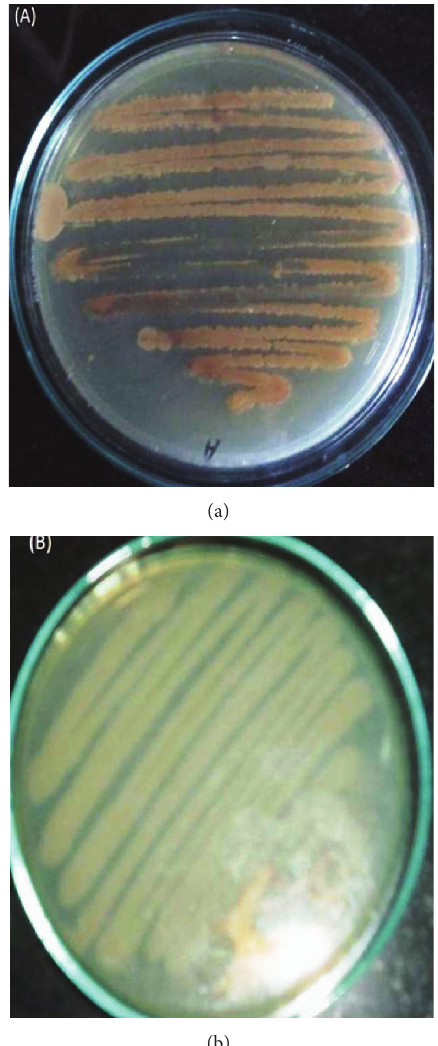
Figure 1: (a) Pink/orange florescence under UV light by PHB producer isolate NAP11. (b) No florescence under UV light by Non- PHB producer with Nile blue A staining by viable colony